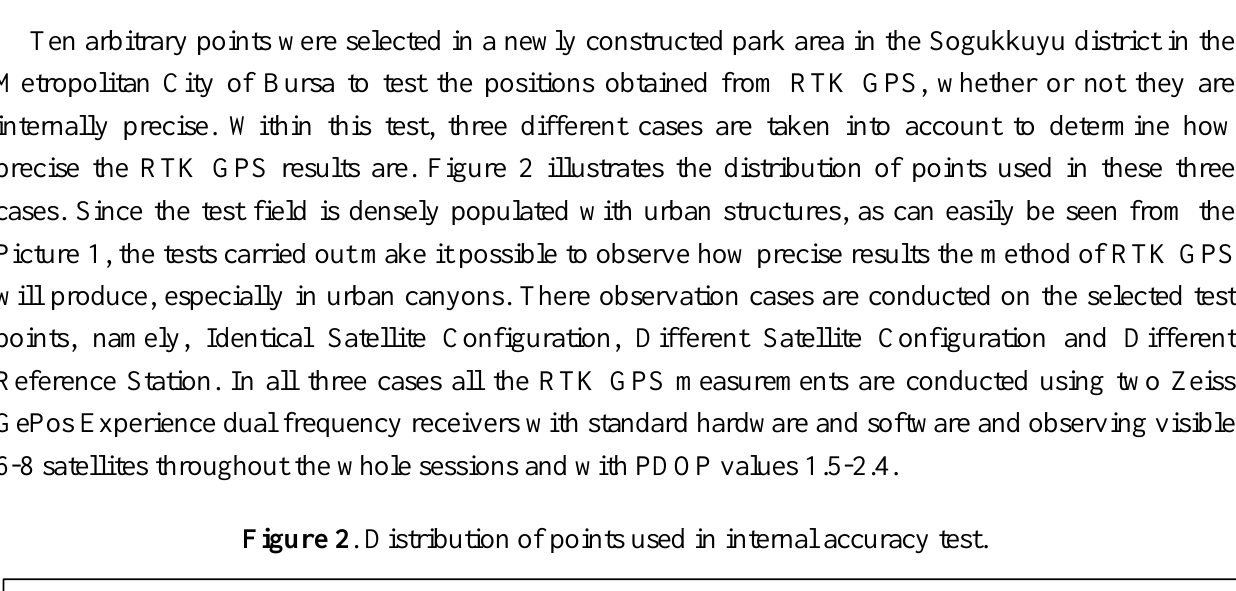
Figure 2 . Distribution of points used in internal accuracy